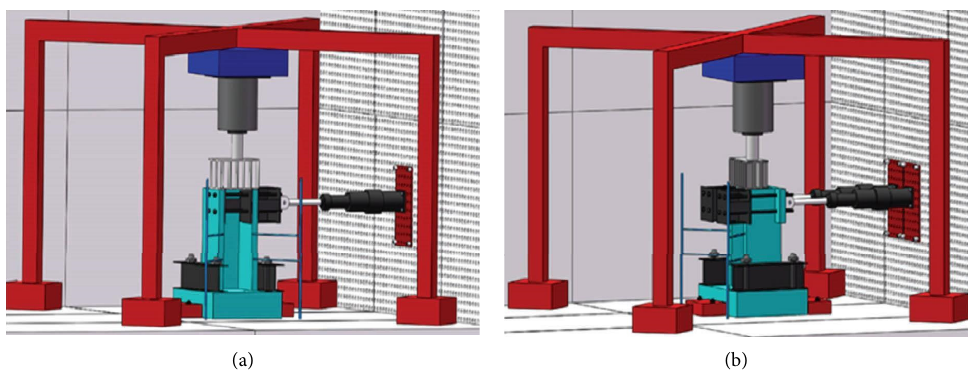
Figure 11: Loading schematics of two specimens. (a) URC-X loading diagram. (b) URC-Y loading diagram.